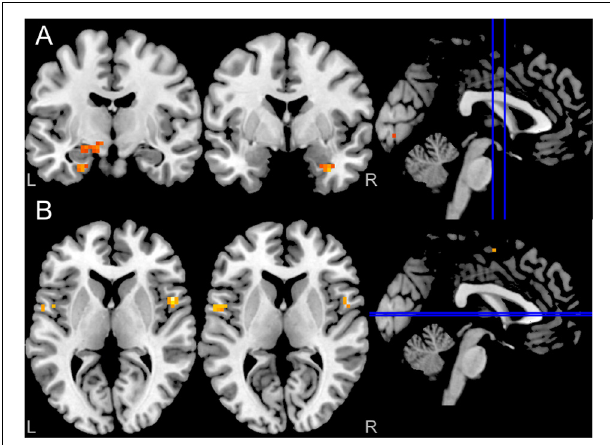
FIGURE 3 | (A) Blood oxygenation level-dependent (BOLD) in response to fearful facial expressions demonstrated increased bilateral amygdala activity ( P < 0.001 uncorrected for ten voxels); (B) Enhanced left amygdala connectivity (PPI) with both insula in response to fearful facial expressions ( P < 0.001 uncorrected for ten voxels). The right amygdala did not show any PPI connectivity (not shown in the